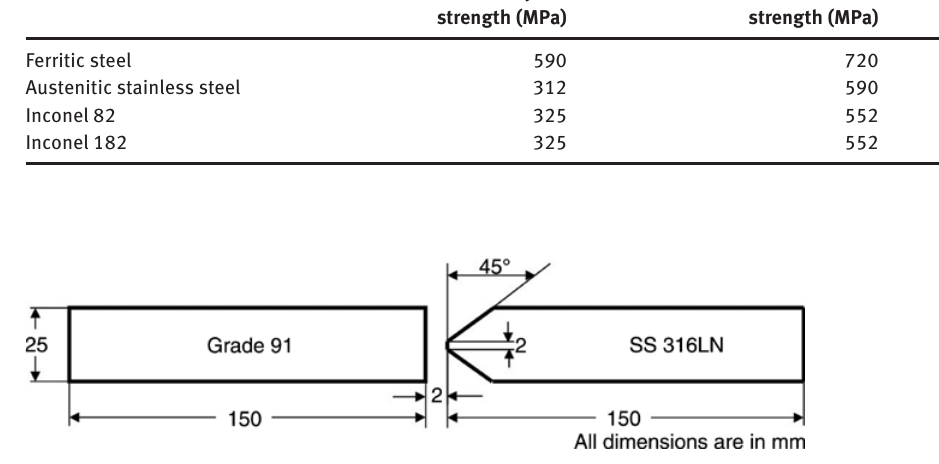
Figure 1: Details of K-joint configuration used in this investigation.